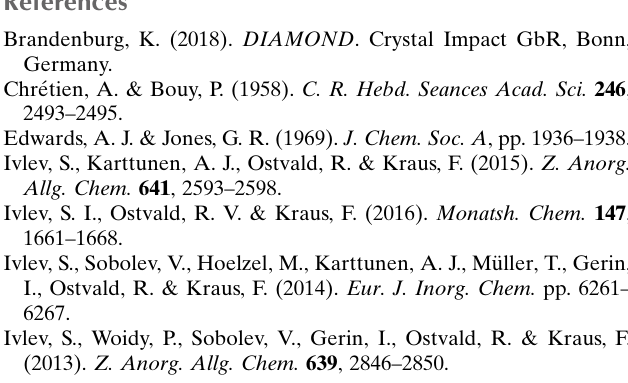
Table 2 Interatomic distances (A˚ ) in known M tetrafluoridobromates(III) ( M = Na, K, Rb, Cs, Ba). Compound Br—F M —F K[BrF 4 ] (at 100 K; this work)